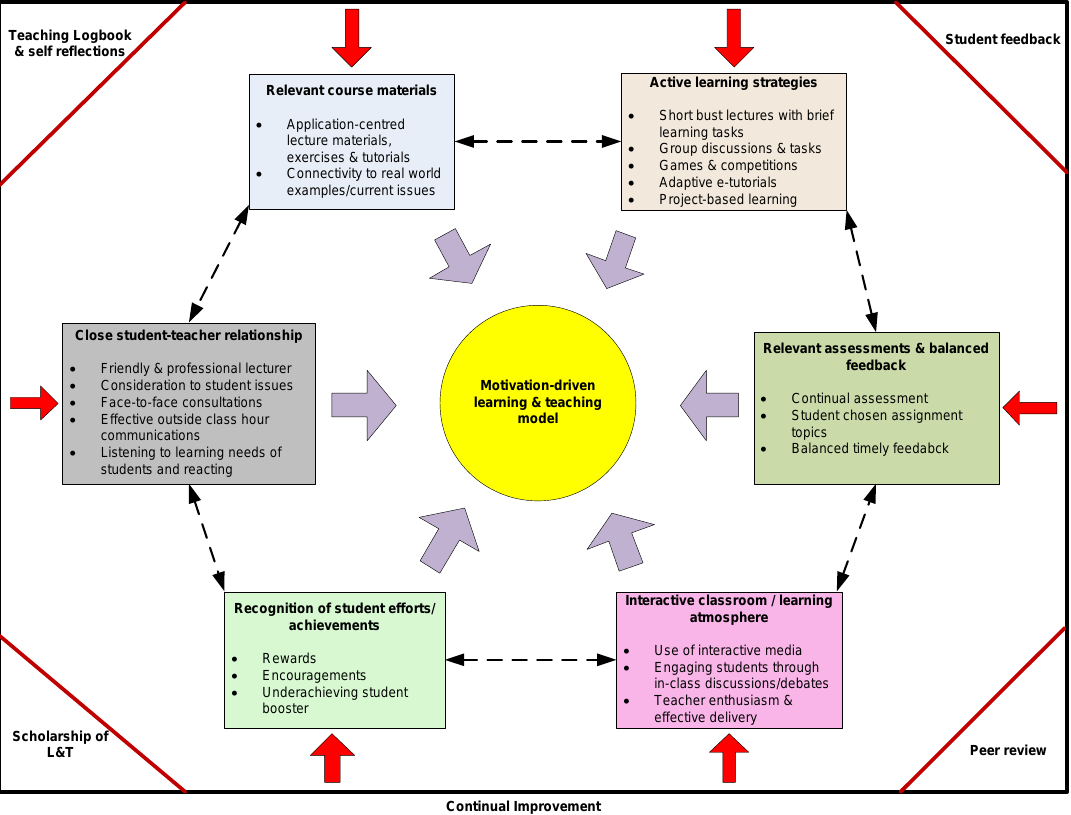
Figure 1 Motivation-driven learning & teaching